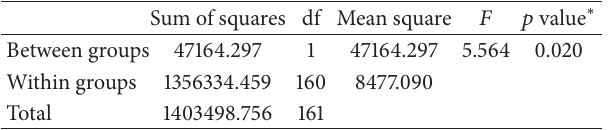
Figure 3: Prevalence of iodine deficiency among both groups before intervention. Table 1: Analysis of covariance table for posttest scores at the end line.